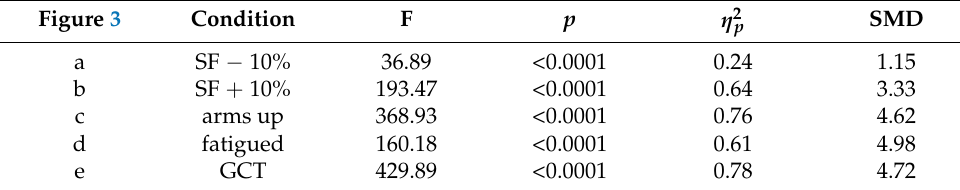
Table 1. Independent ANOVA results for the relation between ˙VO 2 and P W for each condition vs. the expected distribution as determined in the incremental/ramp test. We give a visual interpretation of these results in Figure 3 as trend lines through the measured data points. Effect strengths are given as the standardized mean difference (SMD) and η 2 p as compared to the expected baseline. Figure